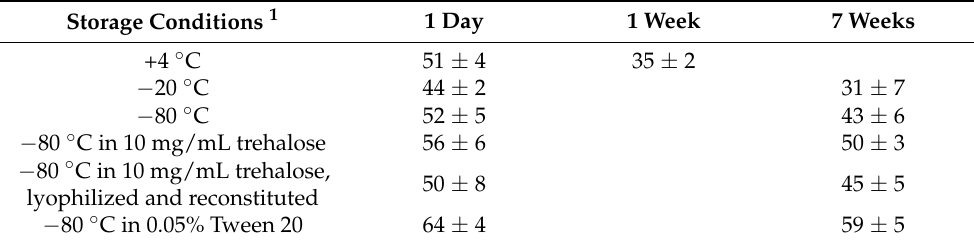
Table 1. Residual protein content in supernatants of vault preparations stored under different conditions. Storage Conditions